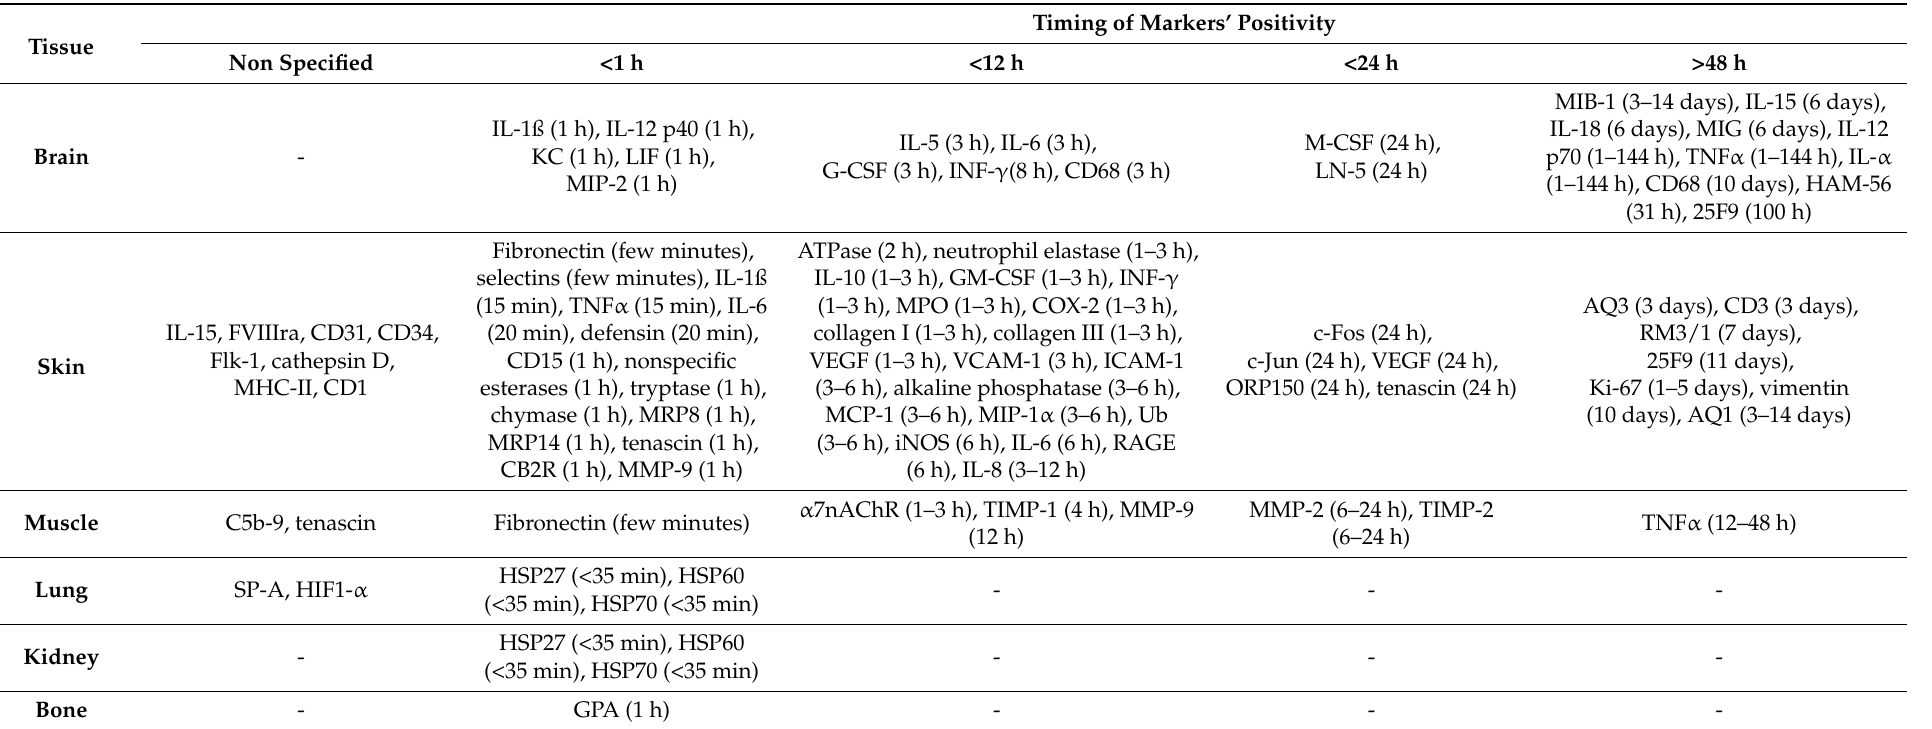
Table 4. This table shows the timing of positivity of immunohistoichemical vitality markers in different tissues after wounding. IL, interleukin; α 7nAChR, α 7 nicotine acetylcholine receptor; A1-ACT, alpha1-antichymotrypsin; RM3/1, anti-CD163 marker; 25F9, mature macrophages marker; GM-CSF, granulocyte macrophage-colony stimulating factor; GPA, glycophorin A; HSP, heat-shock protein; ICAM-1, intercellular adhesion molecule 1; iNOS, inducible nitric oxide synthase; mAb, monoclonal antibody; MCP, monocyte chemoattractant protein; MHC-II, major histocompatibility complex II; MMP, matrix metallopeptidase; RAGE, receptor for advanced glycation endproducts; TNF- α , tumor necrosis factor α ; VEGF, vascular endothelial growth factor; VCAM-1, vascular cell adhesion molecule-1; ATP, adenosine triphosphate; MRP, myeloid-related protein; M-CSF, macrophage colony-stimulating factor; MIG, monokine inducible by interferon gamma; ORP, oxygen regulated protein; HLA, human leukocyte antigen; TGF, transforming growth factor; MPO, myeloperoxidases; COX, cyclooxygenase; CB2R, cannabinoid receptor type 2; SP, surfactant protein; HIF, hypoxia inducible factor; AQ, aquaporin; MIP, macrophage inflammatory protein; CML, carboxymethyllysine; Flk, receptor for vascular growth factor; EPC, endothelial progenitor cell; TIMP, metallopeptidase inhibitor; Chil, chitinase-like; INF, interferon; Ub,